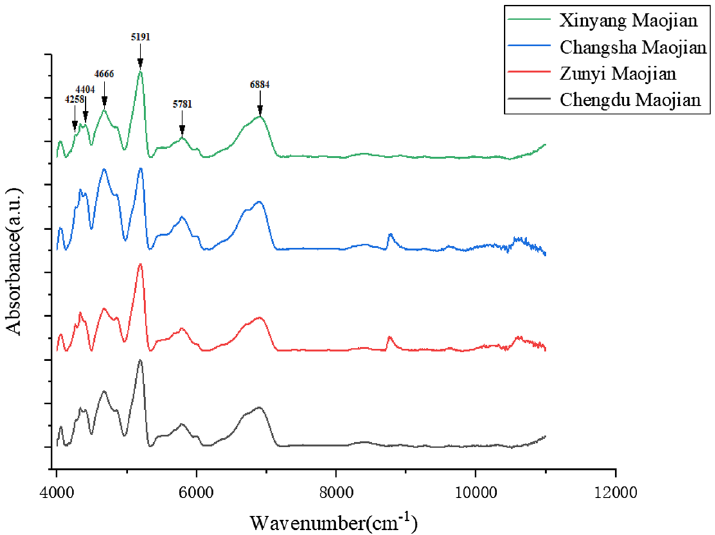
Figure 2. Normalized average spectral stacking line plot of Chengdu Maojian, Zunyi Maojian, Changsha Maojian, Xinyang Maojian.